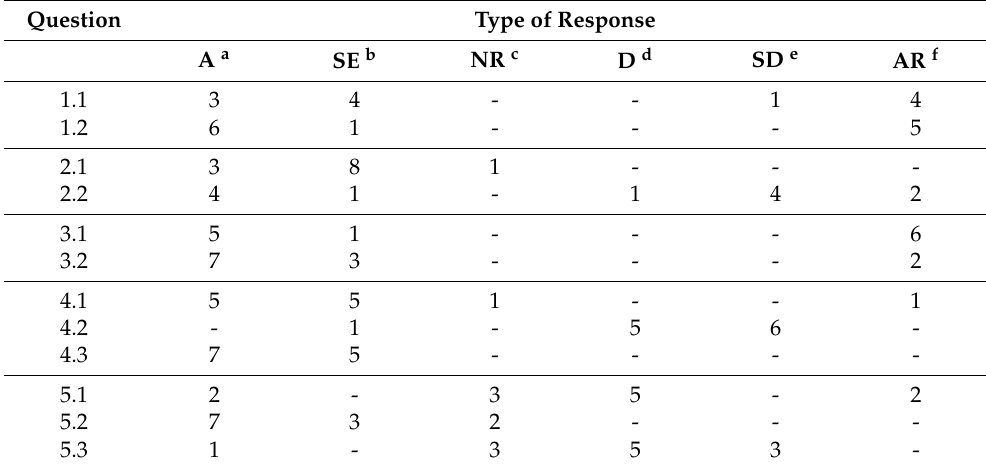
Table 3. Participants’ responses in the health pilot evaluation.